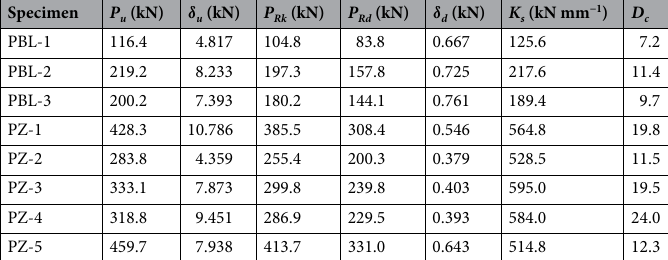
Table 4. Static mechanical property indexes of tested shear